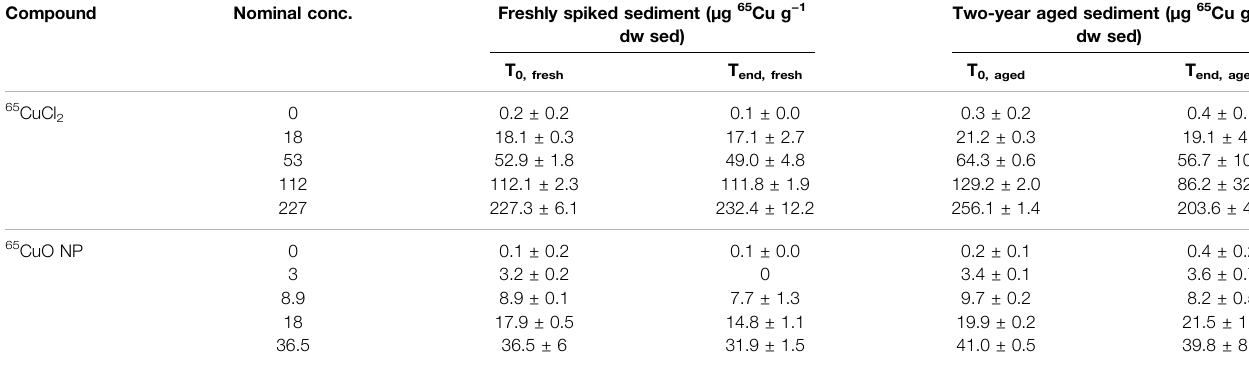
TABLE 1 | Sediment 65 Cu concentrations from experiments with freshly spiked sediment and sediment aged for 2 years. Compound Nominal